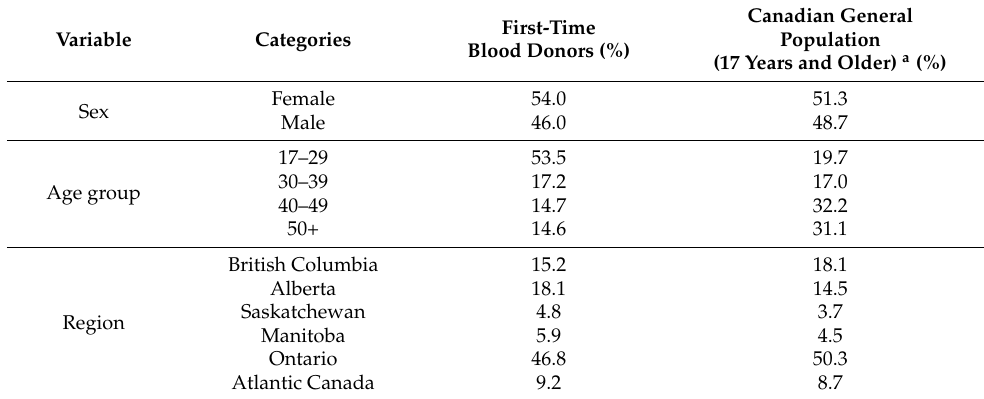
Table 4. Breakdown of the percentage of first-time blood donors (April 2005 to December 2020) by sex, age group, and region compared to the age-eligible Canadian population.